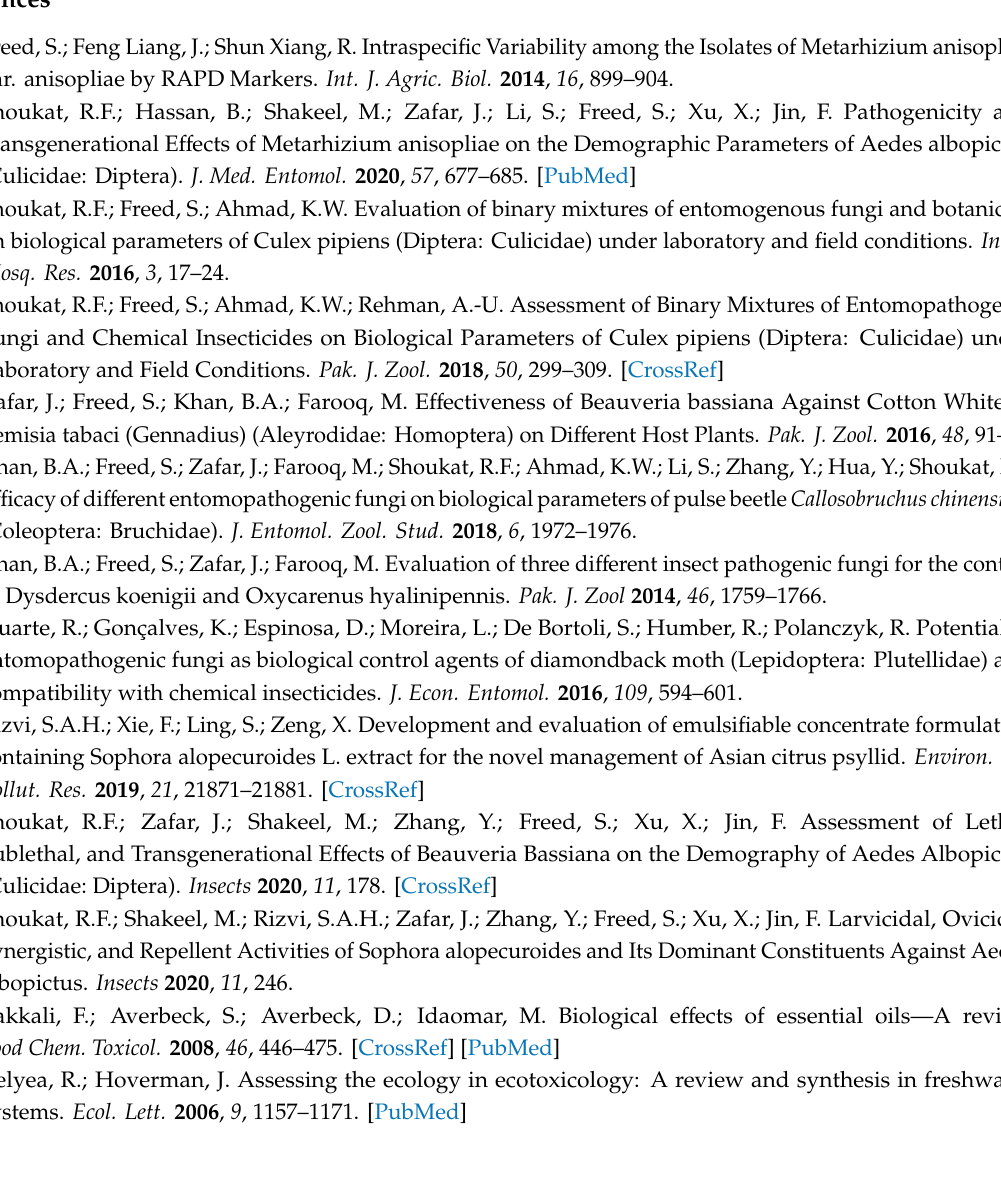
Figure S1: Experimental validation of lethal (LC50) and sublethal (LC20) concentrations of Metarhizium anisopliae. Error bars show 95% confidence intervals (CI), Table S1: Primers used in this